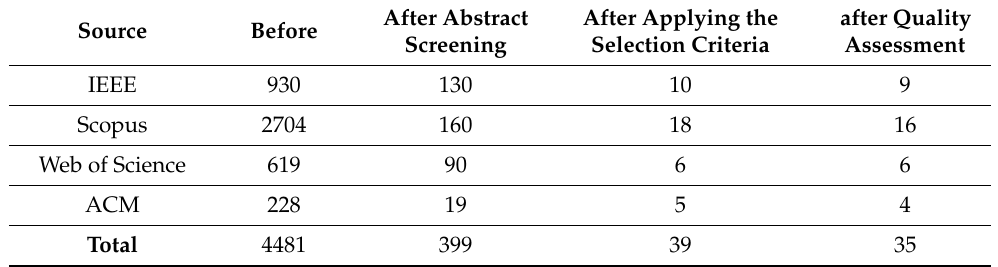
Table 1. Process of paper selection.